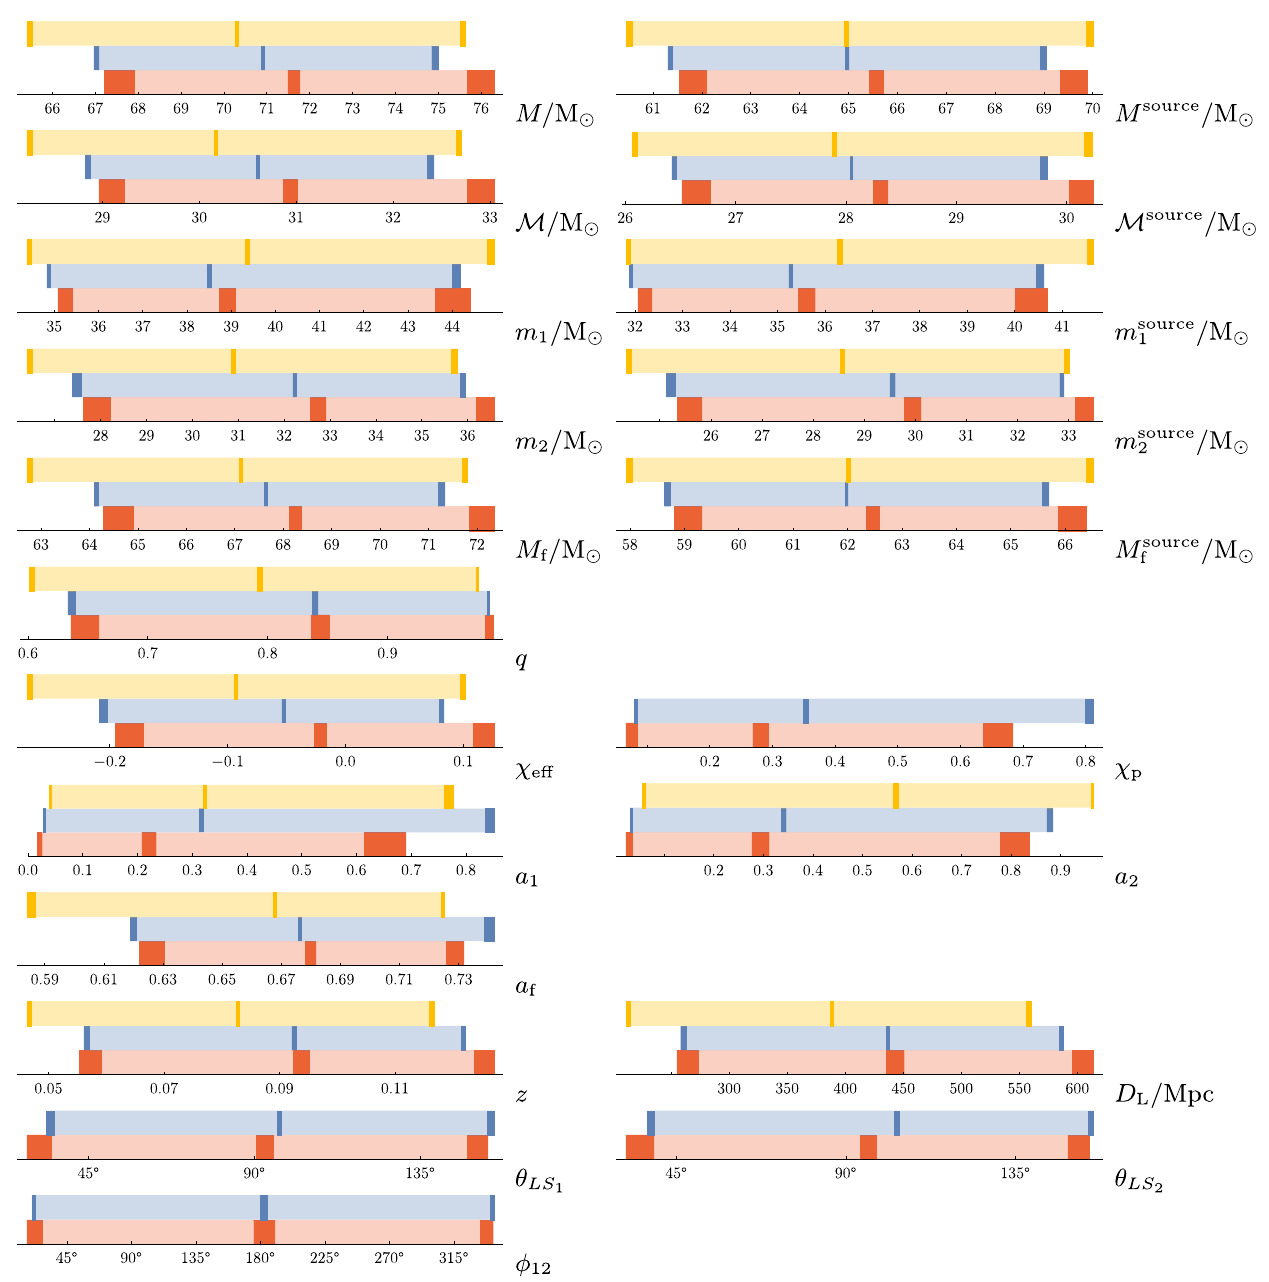
FIG. 1. Comparing nonprecessing EOBNR (light yellow, top), precessing IMRPhenom (light blue, middle), and precessing EOBNR (light red, bottom) 90% credible intervals for select GW150914 source parameters. The darker intervals represent error estimates for (from left to right) the 5%, 50%, and 95% quantiles, estimated by Bayesian